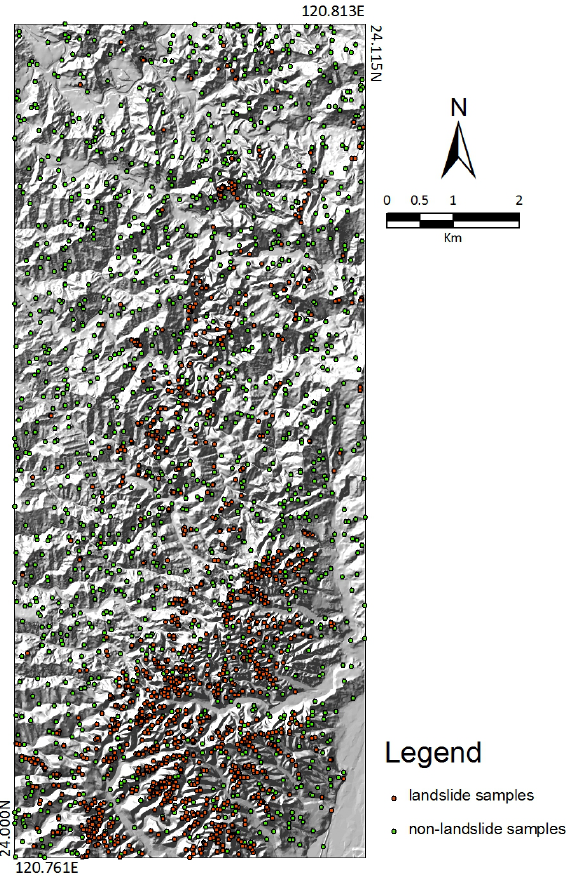
Fig. 10. Distribution of random samples in the logistic